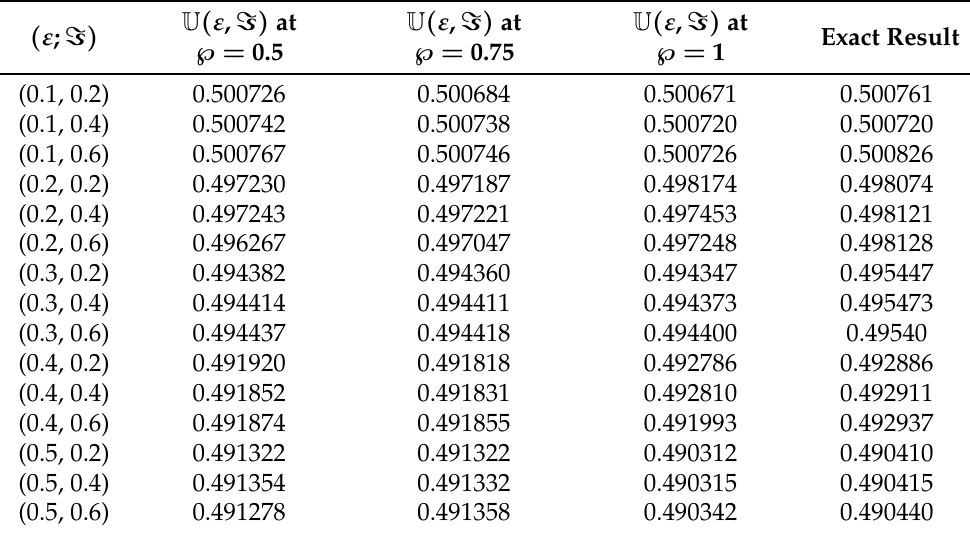
Figure 8. The fractional-order solutions of V ( ε , (cid:61) ) at ℘ of Example 2. Table 5. YDM solution of U ( ε , (cid:61) ) at different fractional-order ℘ of Example